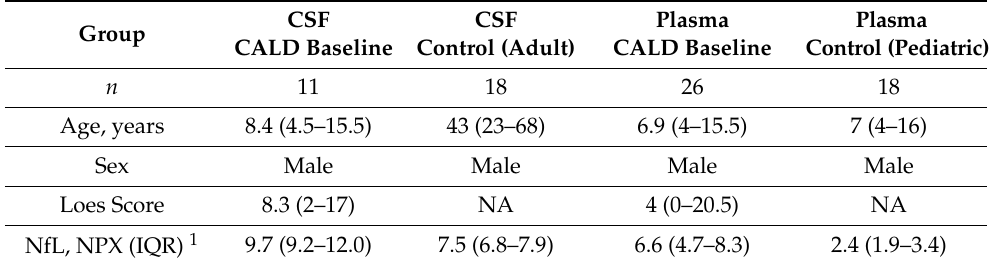
Table 1. Demographics of samples analyzed in this study.